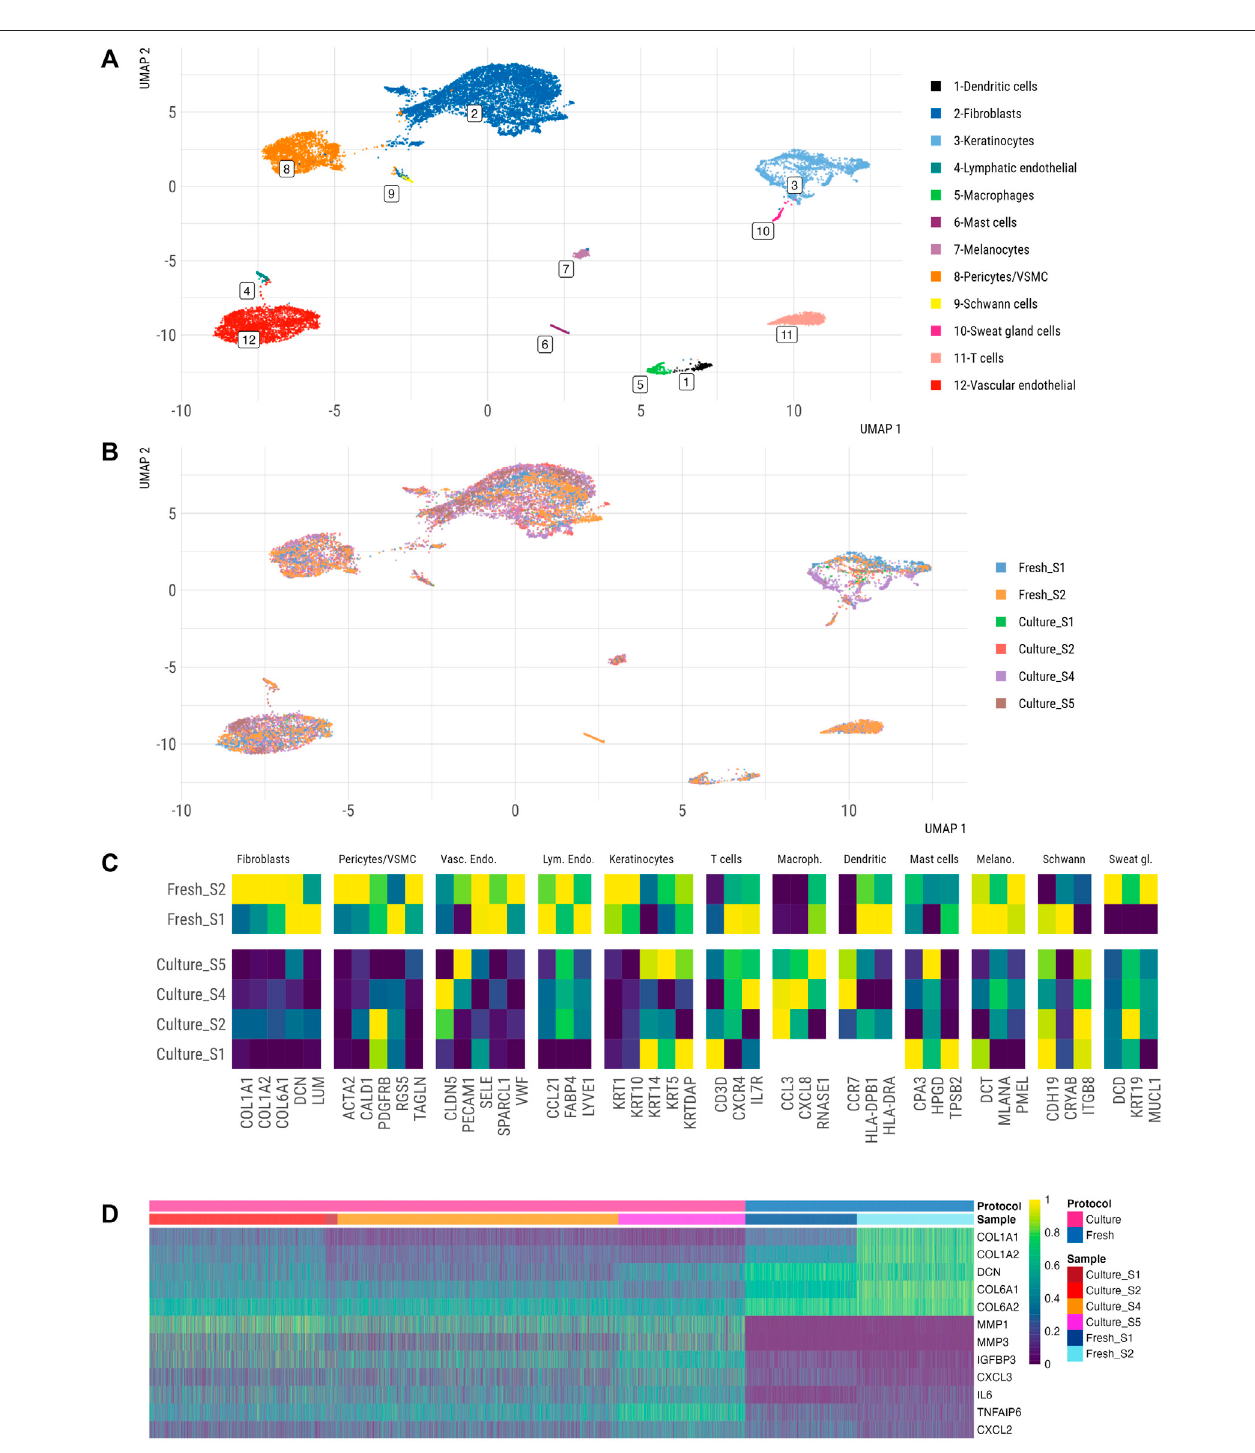
FIGURE6| Singlecellatlasoffreshlyvs. ex-vivo dissociatedhumanskin.UMAPrepresentationoffreshandculturedskinsamples,colouredbyannotatedcelltype (A) and by (B) sample type (fresh vs. cultured). (C) Marker gene expression of 3 – 5 markers of each cluster from healthy vs. cultured skin datasets. Averaged expression ofmarkerswithintheidenti fi edcelltypeisshown.Markergeneswereidenti fi edinanunbiasedfashionblindtoknowncelltypemarkers. (D) Heatmapof fi broblasts ’ gene expression from fresh vs. cultured samples.